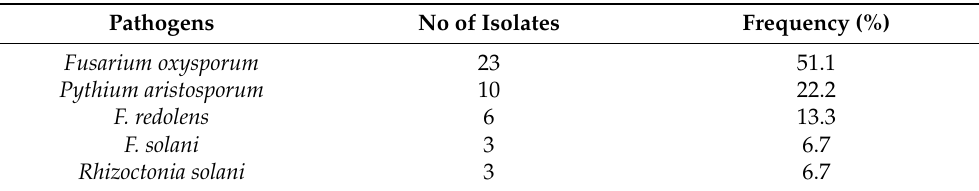
Table 1. Identification of seedling blight pathogens ( n = 45) infecting rice in Heilongjiang province,